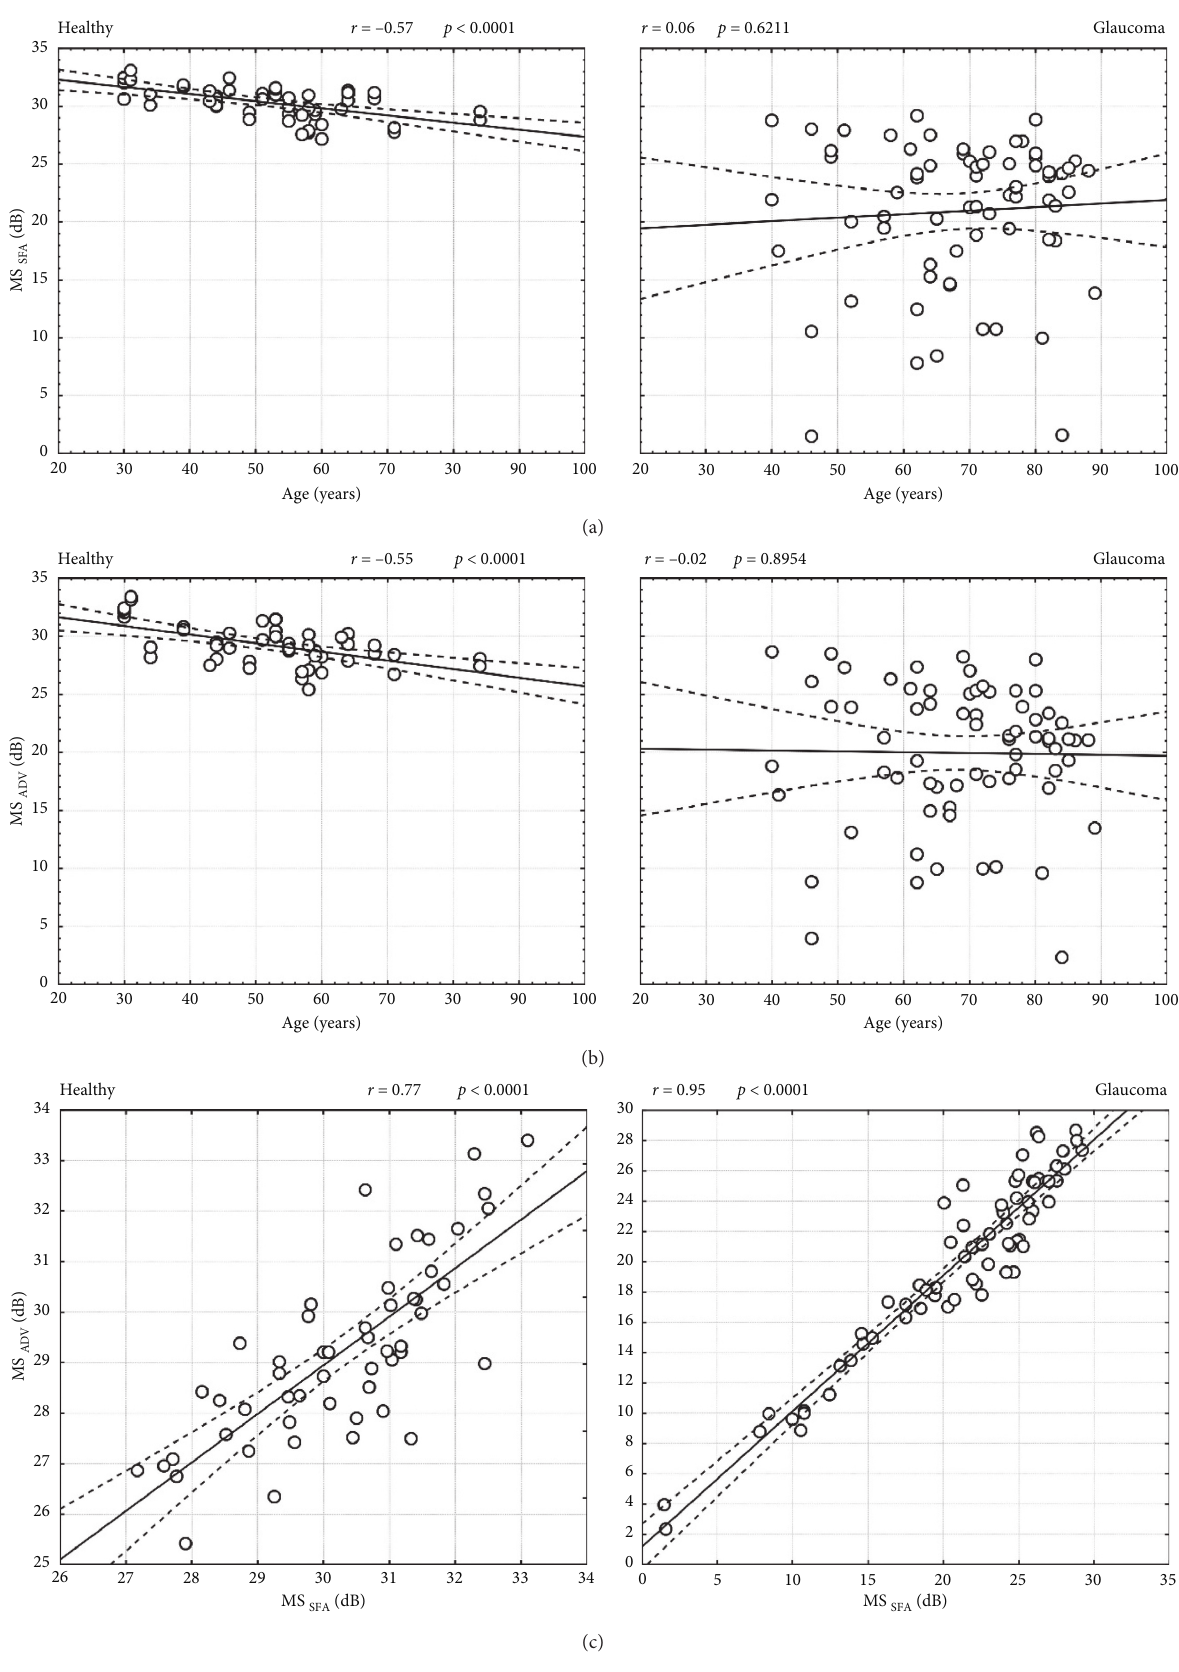
Figure 3: Mean sensitivity analysis in healthy and glaucomatous eyes. (a, b) Correlation of retinal MS with patient age for SFA and ADV strategies; (c) correlation between retinal MS in ADV and SFA